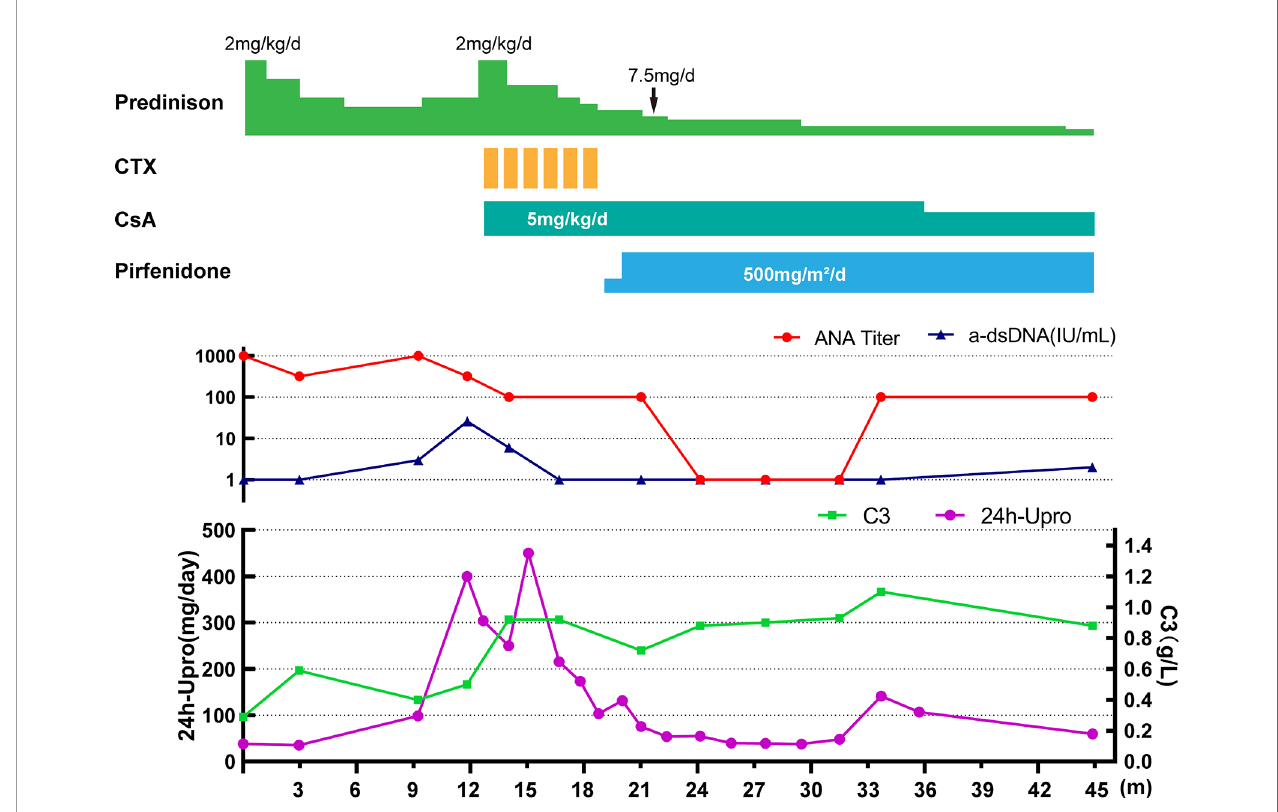
FIGURE 2 | Clinical course of the patient. CTX, cyclophosphamide; CsA, cyclosporin A; 24h-Upro, 24-hour urinary protein